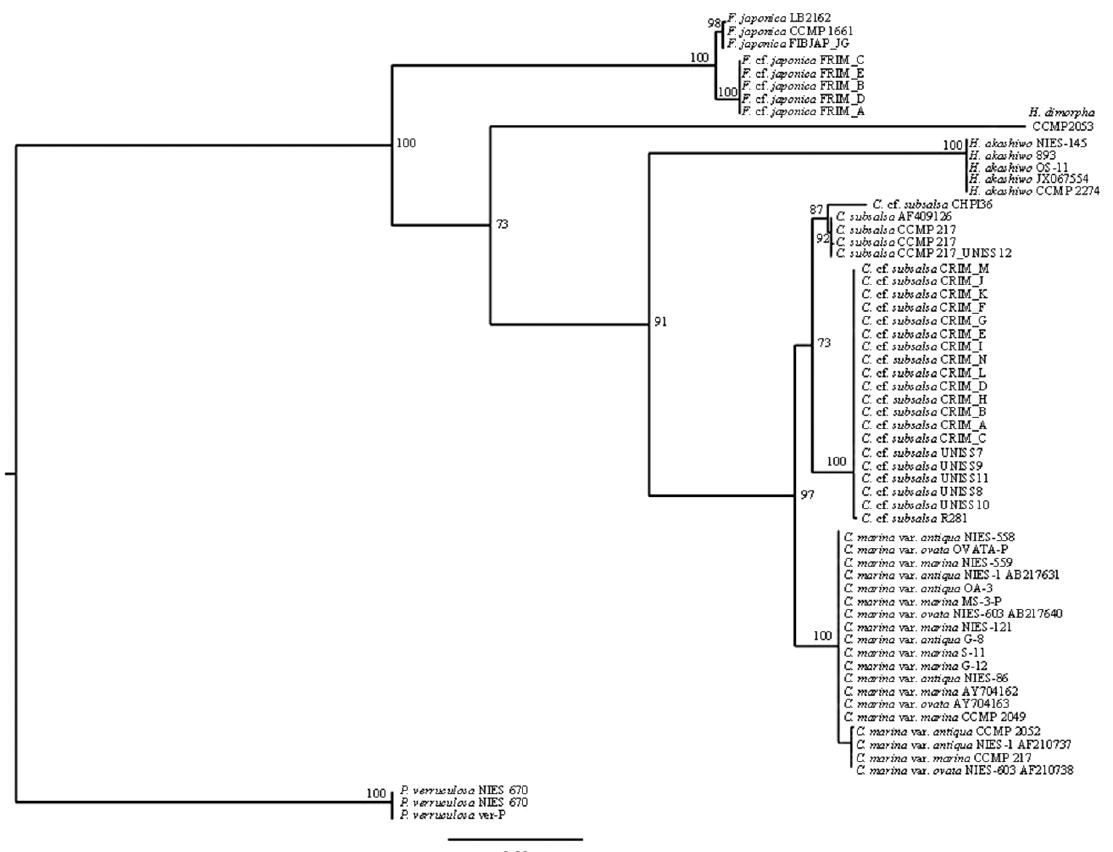
Fig.5. – Maximum likelihood (ML) phylogenetic tree of LSU rDNA sequences among Chattonella -like species. C. subsalsa CCMP217_ UNISS12 is the sequence obtained in this study for the C. subsalsa Global genotype (KR709212), Pseudochattonella verruculosa strains from public databases were used as an outgroup. Bootstrap values (>70%) are shown respectively at each